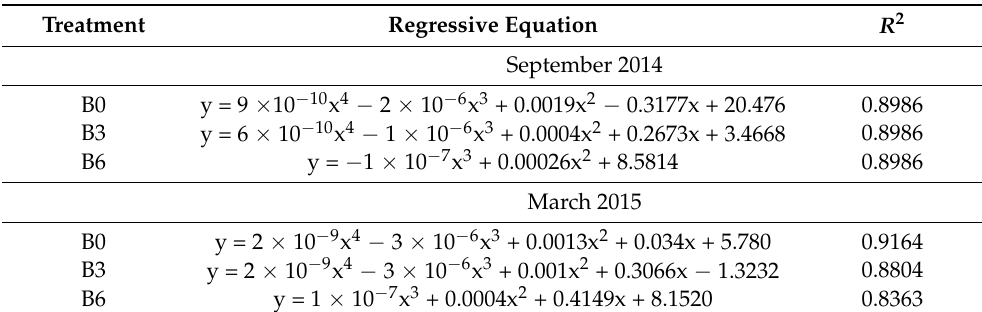
Table 4. Regression analyses were performed using arginine concentration ( µ mol g − 1 DW) in the one-year-old needles of 16-year-old Pinus sylvestris L. as dependent variables (y) and N fertilizers (kg ga − 1 ) as independent variables (x). Polynomial relationships and the coefficients of determination ( R 2 ) were determined for each variant of boron treatment.